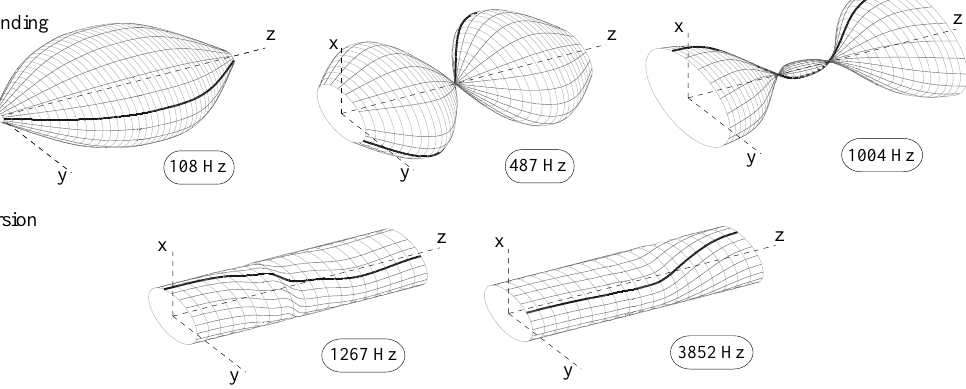
Fig. 2. Eigenmodes of the rotor Ω nom = 50 Hz.